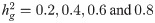
Multiple logistic regression improves fine-mapping in case-control GWAS.We simulated 13082 phenotypes using 100 loci of ∼200 SNPs, as described in the main text. We compared the ranking of SNPs at each locus using recall (solid lines, left y-axis) and precision (dotted lines, right y-axis), which were averaged over 100 loci and 20 simulation replicates. All methods were run with a maximum of two causal SNPs per locus. Panels (a)–(d) show the results at different heritabilities, hg2=0.2,0.4,0.6and0.8. Insets schematically compare the logistic model with the linear model. We plot the true ∑i
xi
βi from the simulation for each individual along the x-axis, and show the distribution of cases and controls on the top and bottom axes respectively. On the y-axis, we show the predicted probability of being causal using a logistic model (p(ϕ = 1), red for cases and green for controls). The black lines are quantile averages of the linear predictor and the logistic predictor. With increasing heritability, the predicted disease probability spreads away from 0.5, where the logistic model becomes increasingly better than the linear model to explain the data and B-LORE shows increasingly more recall over other methods. The improvement by B-LORE over other multi-SNP analyses is more significant than the improvement by multi-SNP over single-SNP analyses.